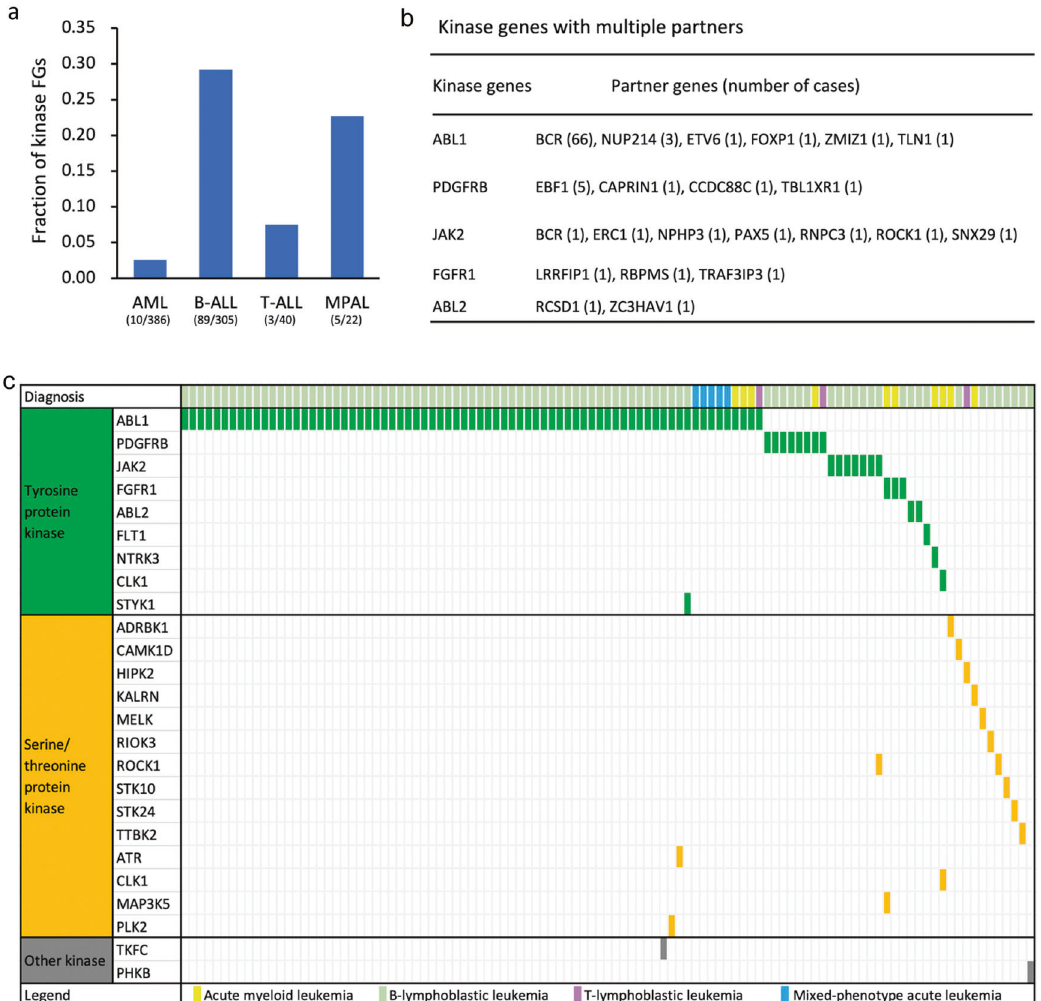
Fig. 3 An overview of protein kinase fusions in acute leukemia. a Bar plots show the fraction of protein kinase fusions relative to the total number of fusion genes per leukemia subtype. b Protein kinase genes with multiple partners. c The landscape of protein kinase fusions in different leukemia subtypes. The horizontal and vertical axes represent the patients and kinase genes, respectively. Genes were ordered based on kinase family annotation. Color bar depicts the diagnosis of each